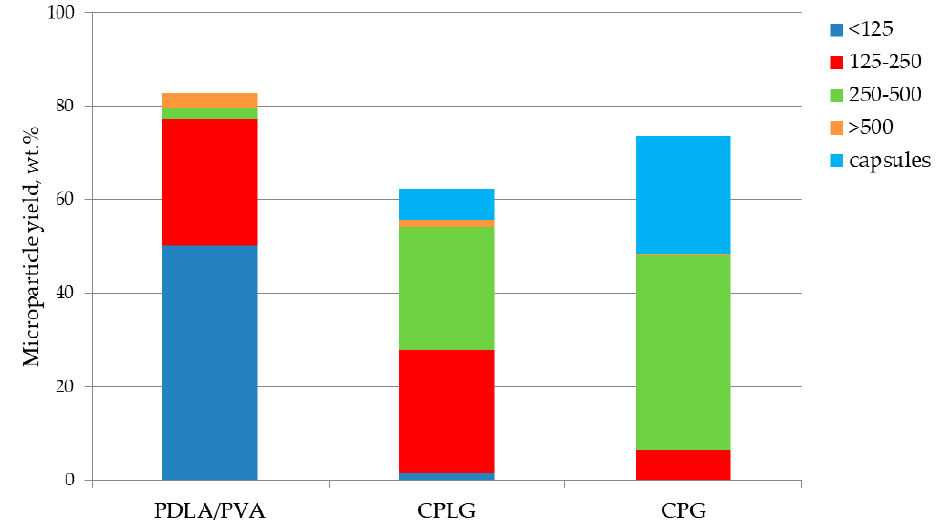
Figure 1. E ff ect of 30 wt. % replacement of PDLA in oil phase by CPG or CPLG copolymers on the processing yield and size distribution of the microspheres and capsule formation.